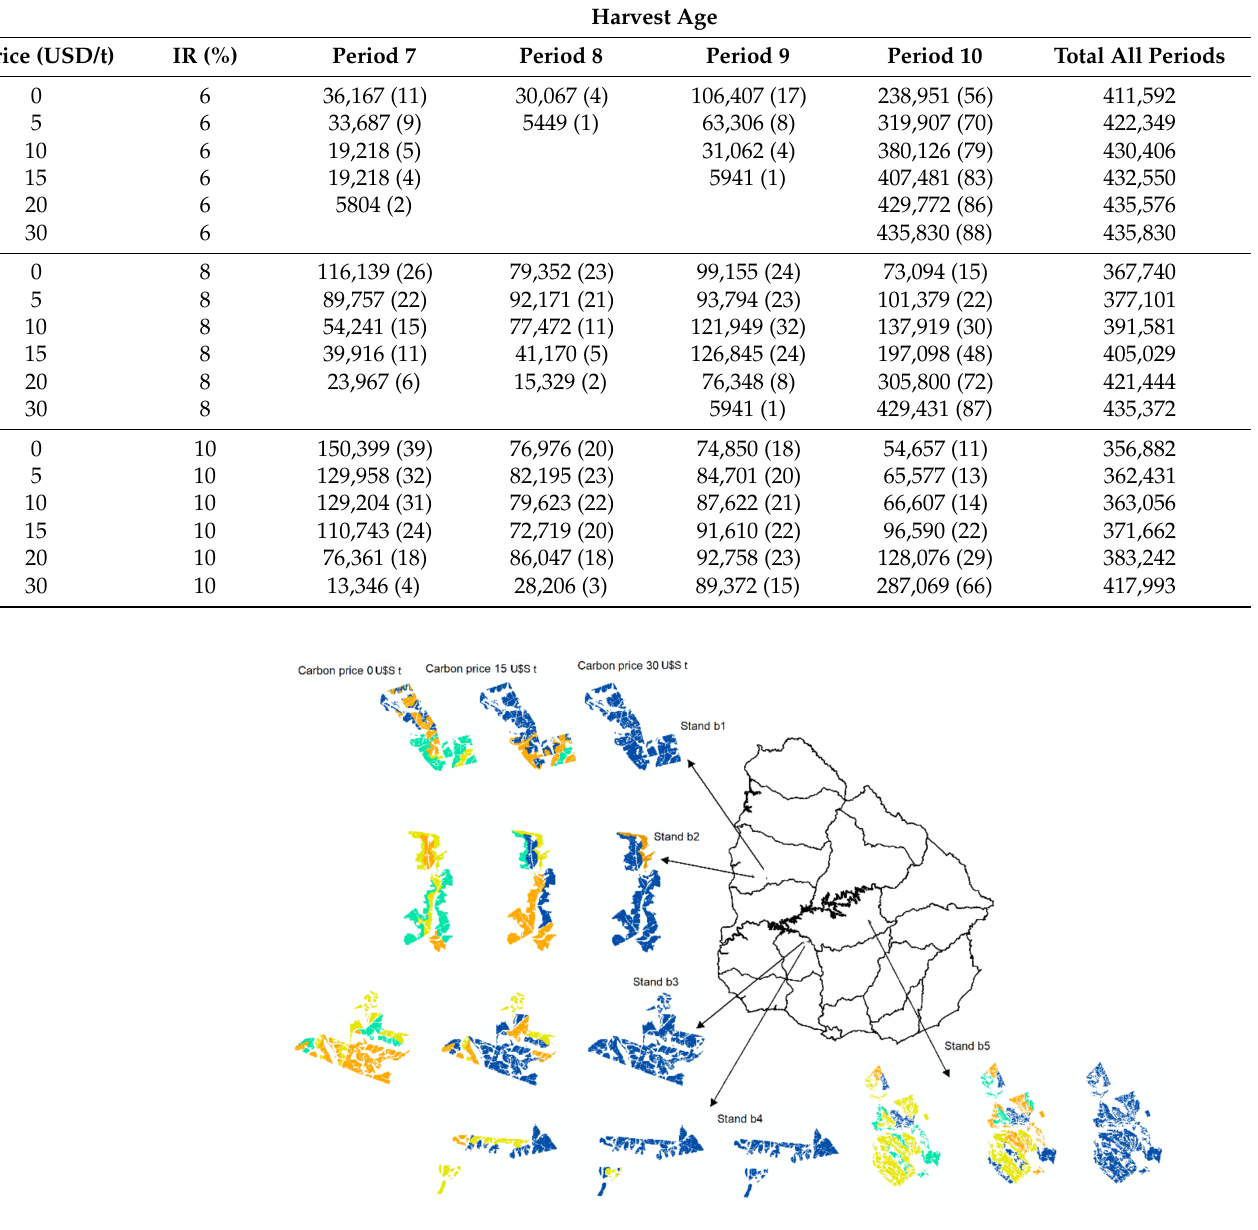
Table 4. Total volume harvested (m 3 ) by harvest age, C price, and IR. Numbers in parentheses represent the number of stands being harvested in each scenario. The last column shows the total volume including all the periods. Values were calculated for a timber price of 65 USD m − 3 and considering 50% of C released at the harvest time.